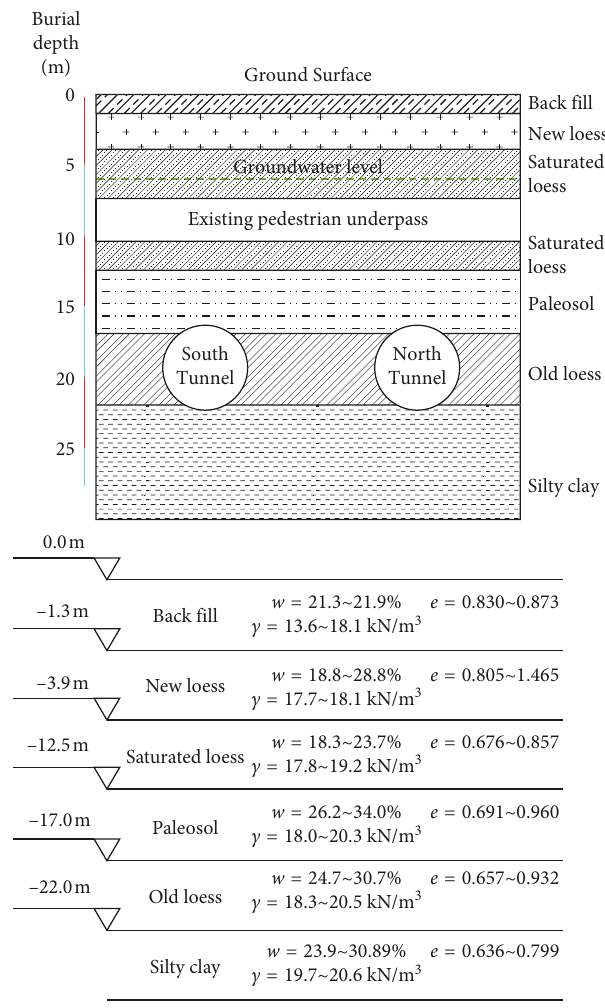
Figure 6: Typical geological profile of the project.